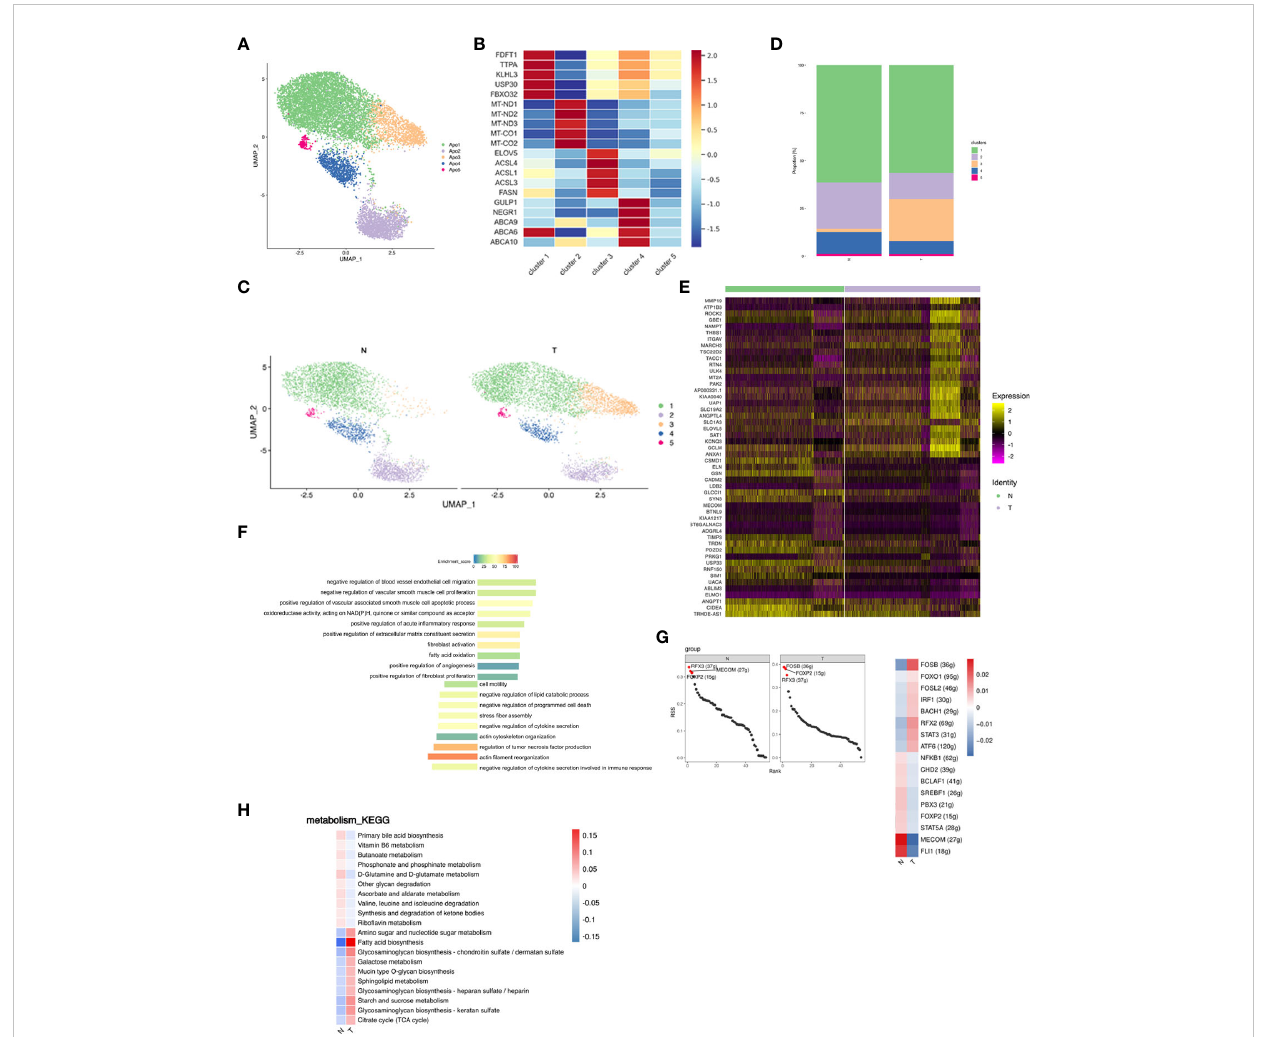
FIGURE 5 Adipocyte subpopulations in adipose tissue are changed by breast cancer. (A) UMAP plot of 5 clusters of adipocytes from the 6 samples pro fi led in this study, with each cell color coded to indicate the associated subclusters and cell numbers. (B) Heatmap showing the expression of adipocyte subpopulation marker genes in each cluster. The color changes from blue to red, indicating a low to high fold change. (C) UMAP plot of all adipocyte subpopulations annotated in each group with each cell color coded to indicate the associated subclusters. (D) The relative ratio of adipocytes in N and T group shown using bar plots, with each cell color coded to indicate the associated subclusters. (E) Heatmap showing the top 25 differential expression analysis of genes (up- or down-regulated). The color changes from blue to red, indicating a low to high fold change. (F) Barplot showing the signi fi cance levels of the top 10 most signi fi cantly enriched pathways in all DEGs. The left side of the coordinate axis represents the enriched functional pathway of down-regulated genes; The right side of the coordinate axis represents the enriched functional pathway of up-regulated genes. (G) The regulon speci fi city score (RSS) ranking plot of top 3 TFs in N and T group. The abscissa represents the ranking, and the ordinate represents the RSS score. The regulator with higher RSS may be related to the speci fi city of this cell group (left). Heatmap showing the regulon activity in N and T group. Rows represent different regulons, and columns represent different cell populations. The color changes from blue to red, indicating a low to high RSS speci fi city score. The higher the RSS score, the stronger the speci fi city of regulon in this cell group (right). The number of target genes shown in brackets. (H) Heatmap indicating the enrichment of metabolism signaling pathway on all adipocytes in N and T